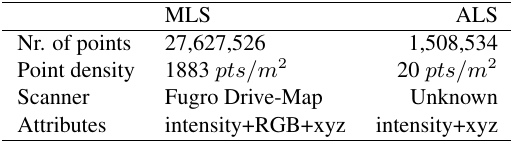
Table 1: Information on multiple platform point clouds